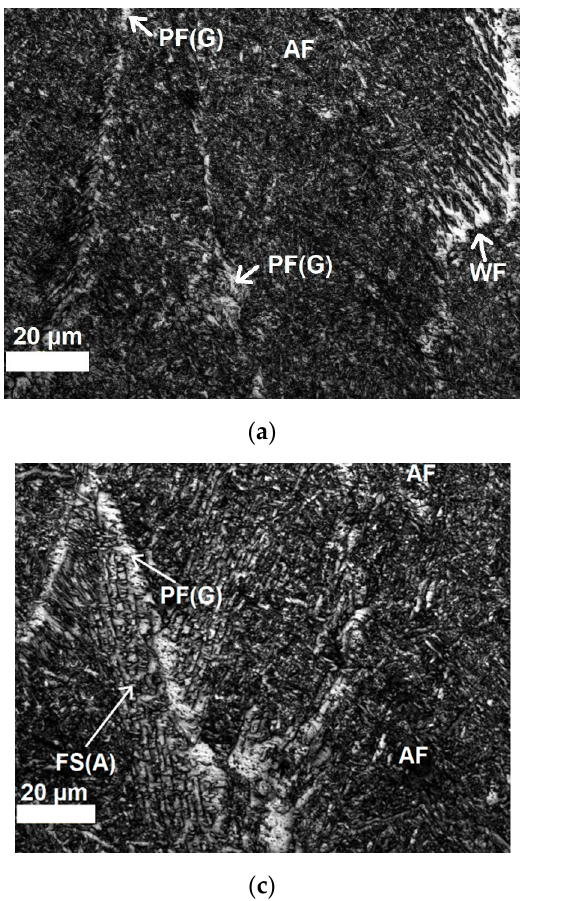
Figure 5. ( a ) Optical microscopy (magnification 200×) and ( b ) scanning electron microscopy (magnification 4000×) of base metal in sample 1. Etching: Nital 5%. P = Pearlite, PF = Primary Ferrite.